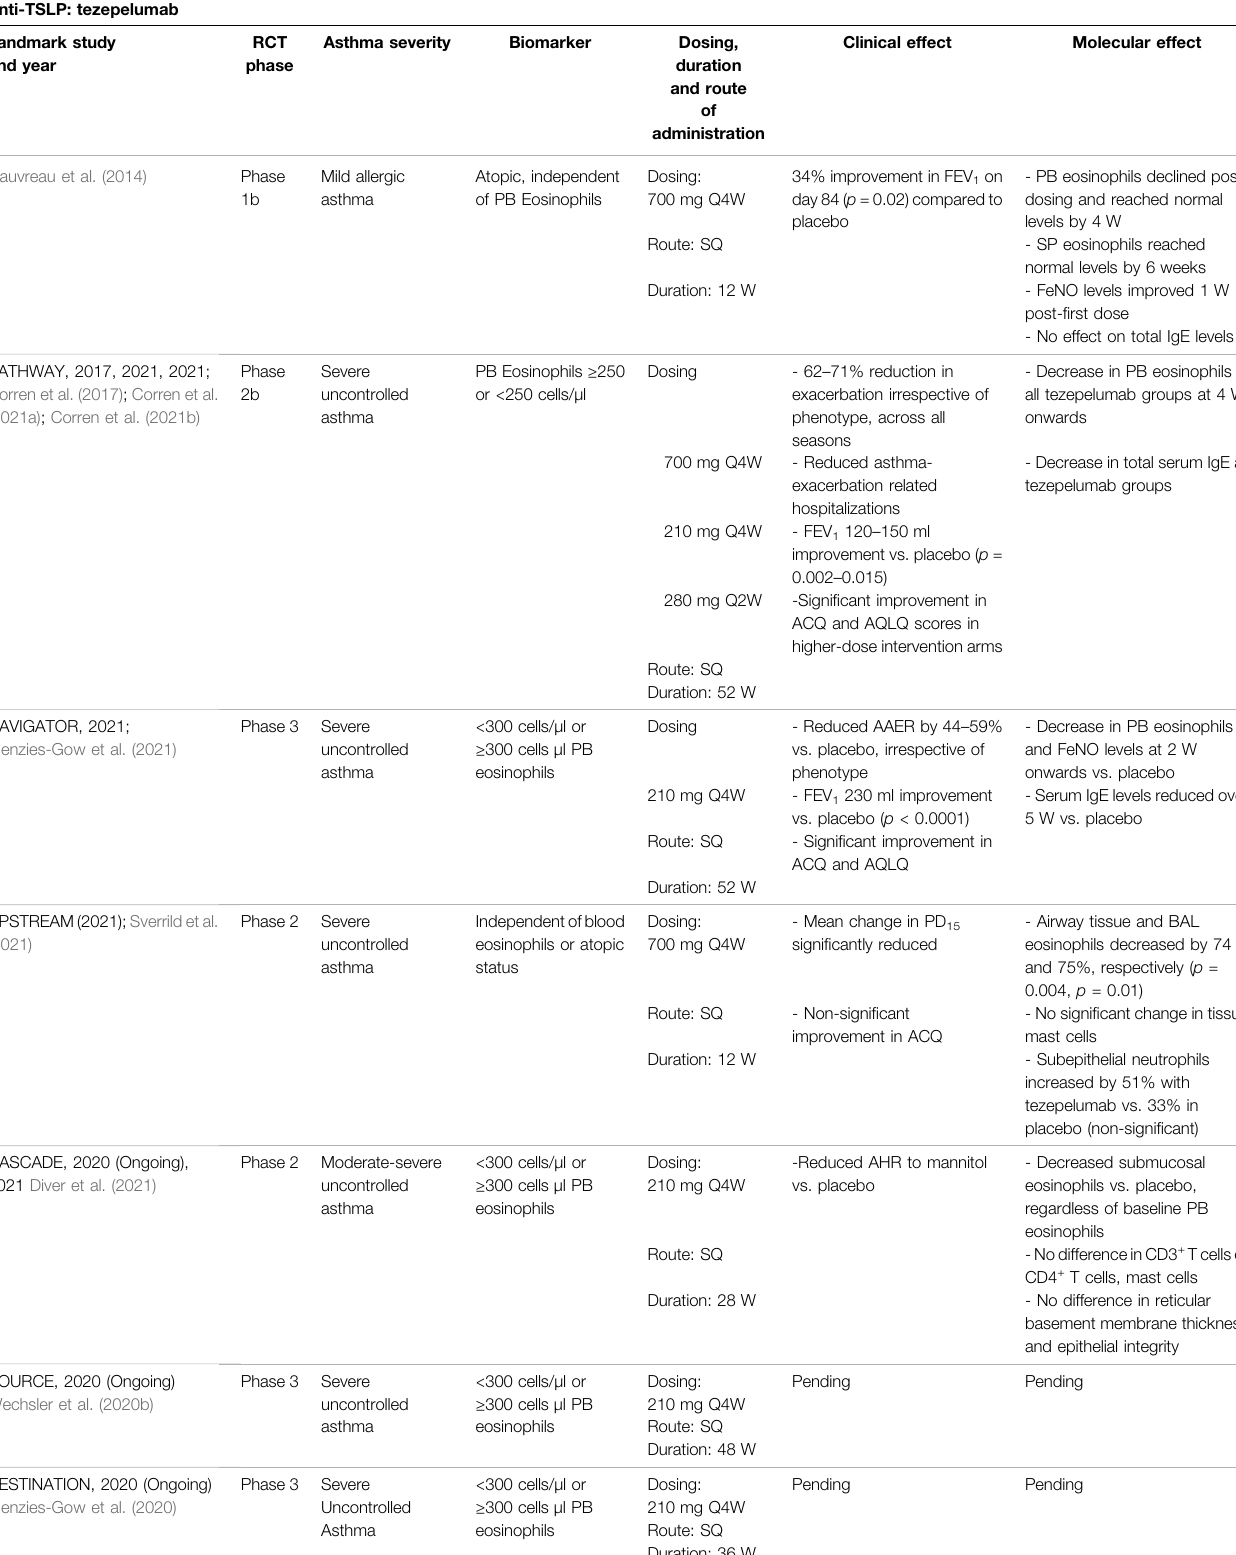
TABLE 6 | Summary of randomized clinical trials assessing tezepelumab in severe